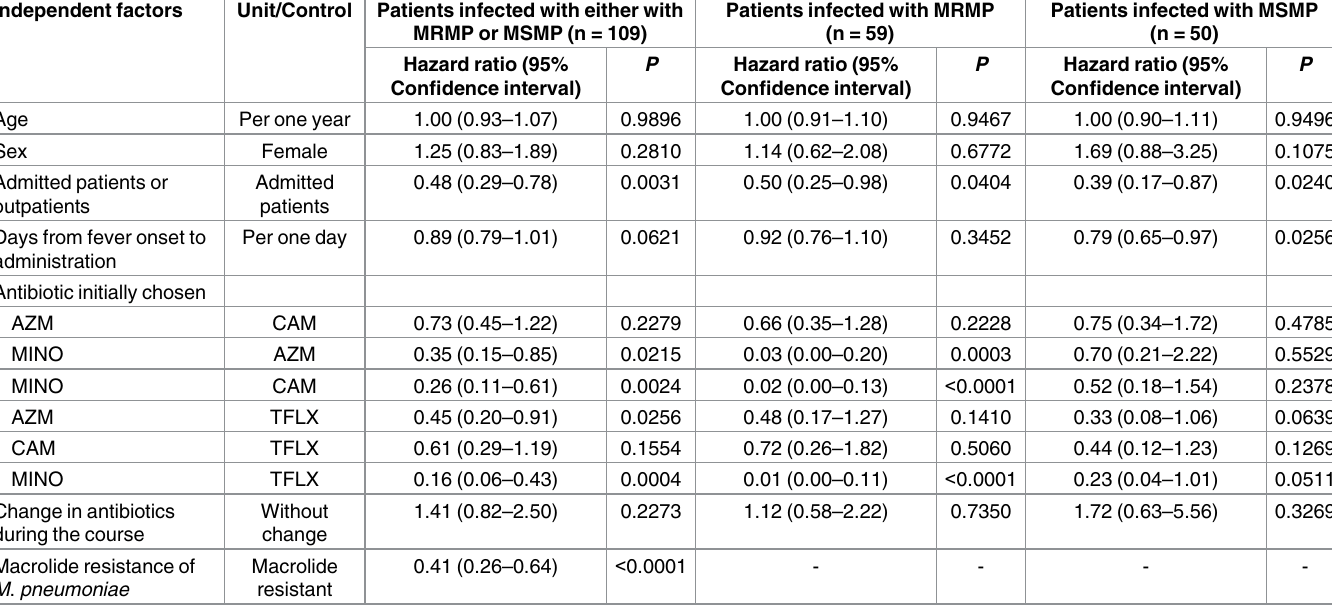
Table 3. Results of analysis using the Cox proportional hazards model to determine factors influencing duration of fever following commence- ment of treatment. Independent